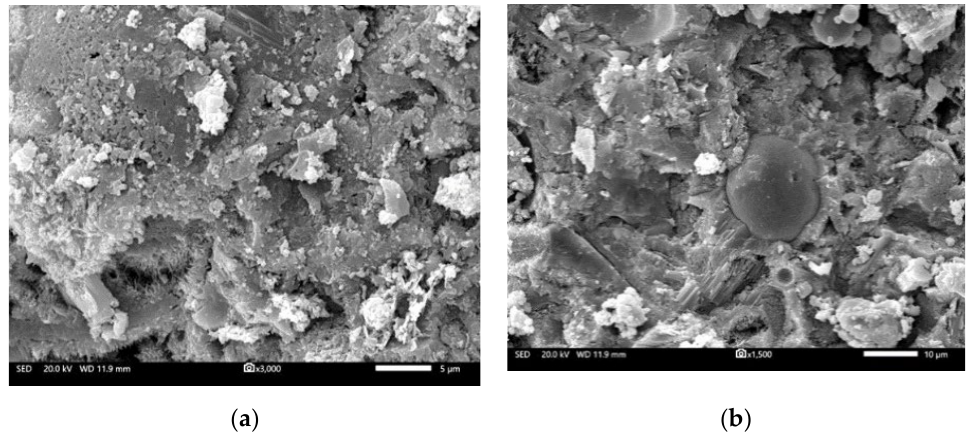
Figure 13. SEM pictures of FA25-P under the FC3 condition, ( a ) Microstructure and ( b ) FA particles in paste.